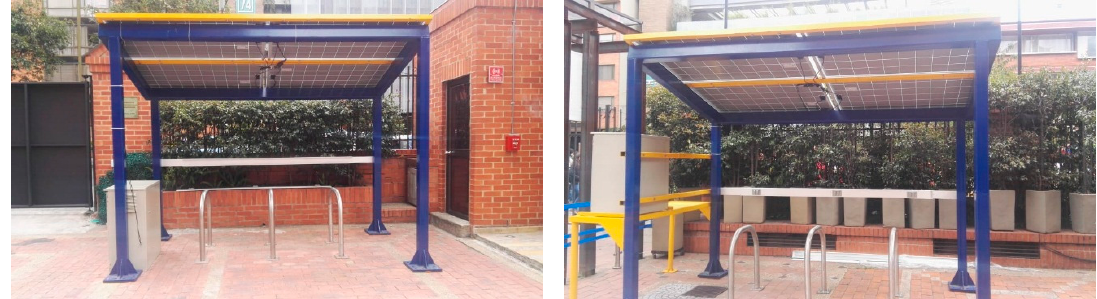
Figure 27. BiCiSOLAR charging station. East charging station ( left ) and west charging station ( right ).